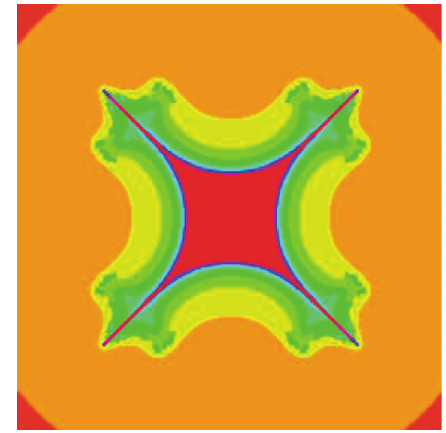
Figure 12: Relative superior multicorn for 𝑠 = 0.3 and 𝑠 󸀠 = 0.8 .